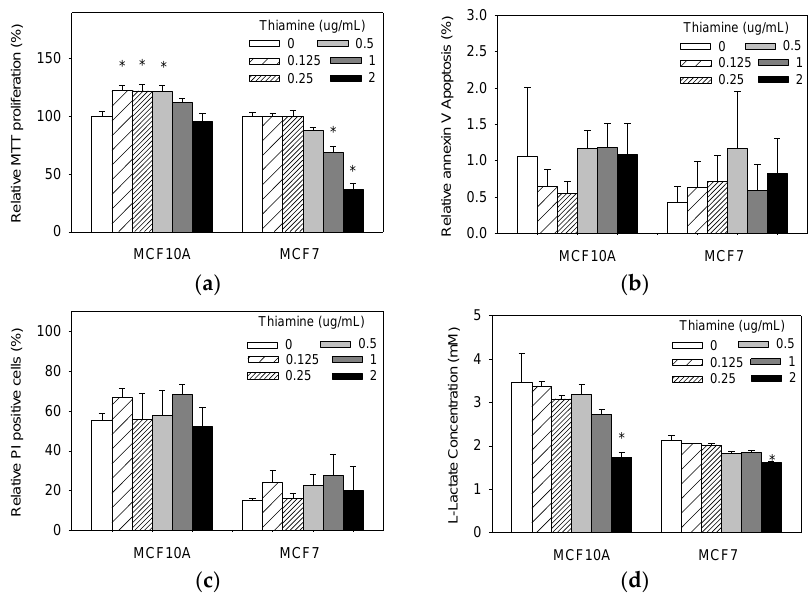
Figure 1. ( a ) Thiamine (1 μg/mL and 2 μg/mL) did not significantly reduce growth of cultures of non-tumorigenic MCF10A cells, but did cause a significant reduction in the growth of cultures of breast cancer MCF7 cells ( p < 0.05). ( b ) % of cells that were Annexin-V positive. ( c ) % of cells that were propidium iodide (PI) staining positive. ( d ) Thiamine reduced lactate levels in growth media in a dose-dependent manner in both cancer and non-tumorigenic cells. Cells were treated with various doses of thiamine or vehicle control, and the relative number of viable cells was assessed at 24 h using MTT assay for ( a ) Annexin-V assay for ( b ) and propidium iodide assay for ( c ). Data are expressed as percentage of control (0 μg/mL thiamine) for ( a – c ). Extracellular lactate levels were measured in the growth media using a L-lactate assay kit for ( d ). Results are expressed as means ± SE (* significant difference relative to control (0 μg/mL thiamine supplementation), white bar).